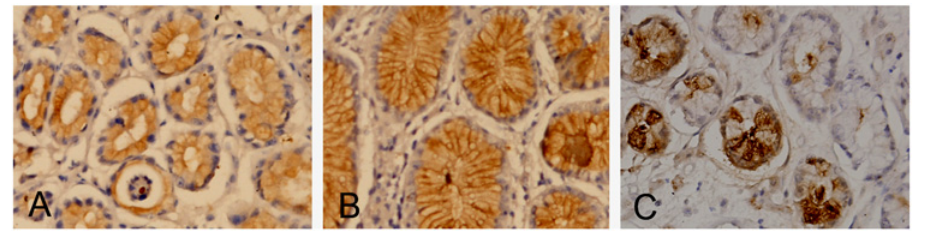
Fig 1. Protein expression of FHIT, IL-8 and P73 showed by immunohistochemical staining of gastric mucosa specimens from patients without both H . pylori infection and family histories of gastric cancer. A. Expression of FHIT, ×40; B. Expression of IL-8, ×40; C. Expression of P73,